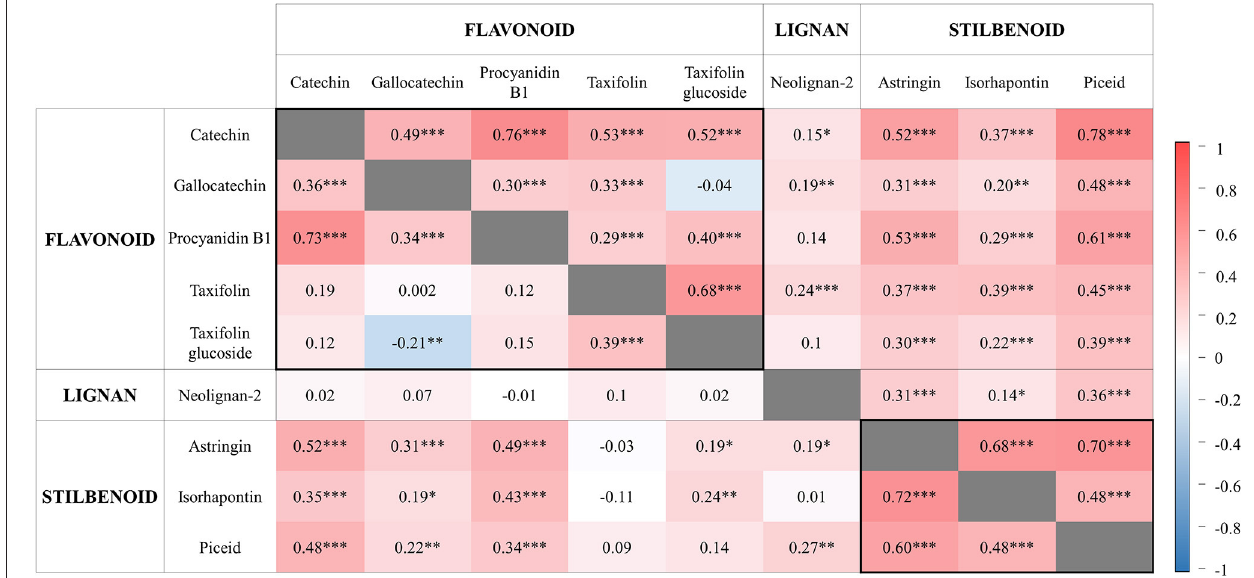
( Figure 4C ). Among the 603 DEGs, 436 were